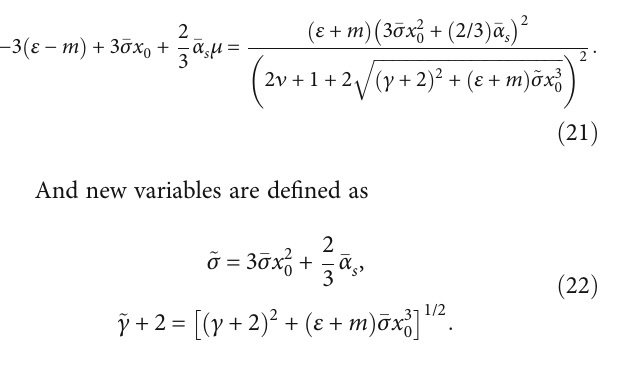
Figure 2. As expected, the wave function peak height grows larger as the baryon mass increases. By obtaining energy,